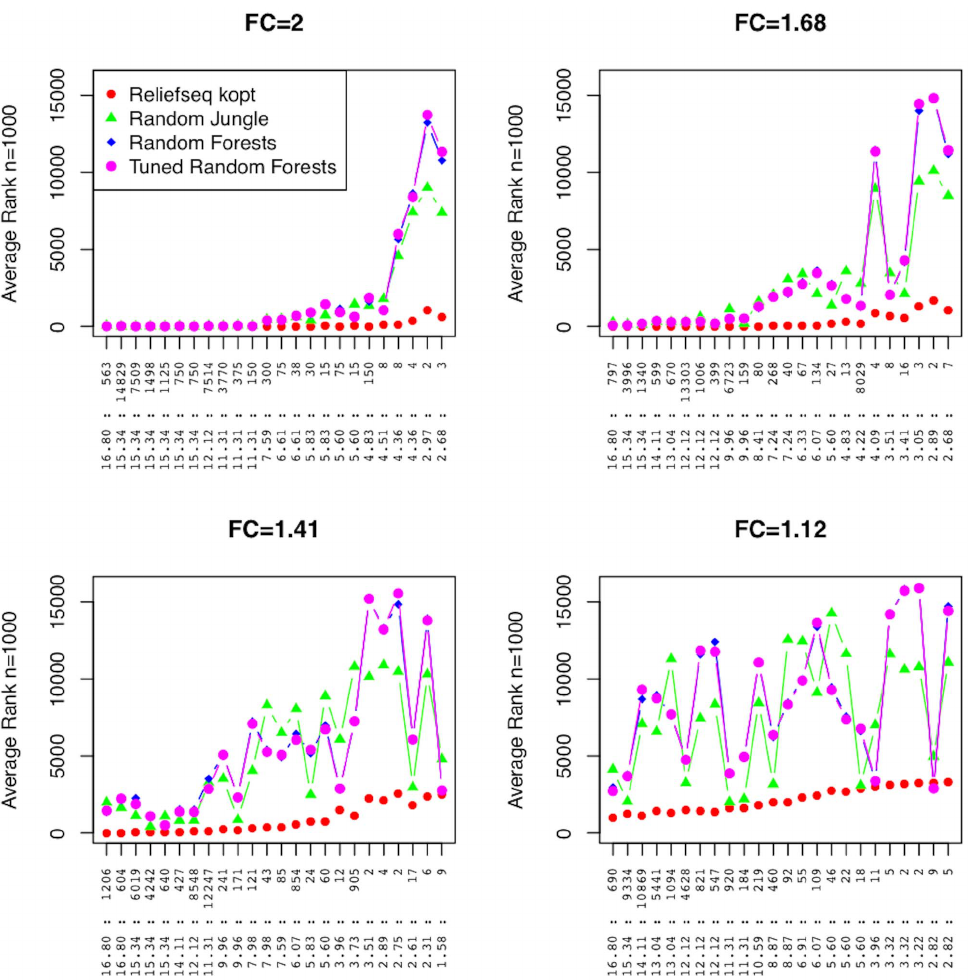
Figure 7. Main effect simulation results comparing gene-wise adaptive-k ReliefSeq and multiple Random Forest implementations. Same panels and axes as in Figs. 5 and 6, but Relief-F with optimized k nearest neighbors is compared with Random Jungle, Random Forest (R implementation), and tuned Random Forest with optimized mtry. Average ranks of the 96 main effect genes simulated in each data set together with null genes for a total of 16,920 genes. The 96 genes are split into four panels based on fold change (FC). The horizontal axis of each plot is labeled by the combination of negative binomial parameters ( h : m ) of the main effect gene. Each point is the average rank across n=1000 replicate simulations.